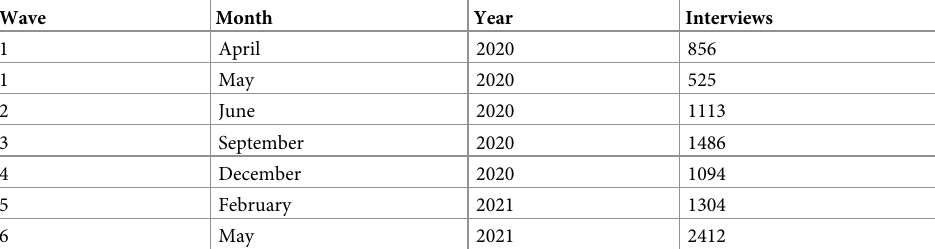
Table 1. Number of BICS interviews administered